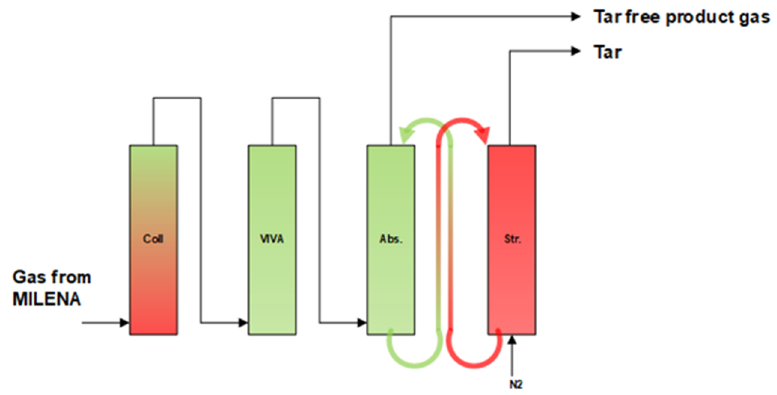
Figure 3. Scheme of the OLGA tar removal system.